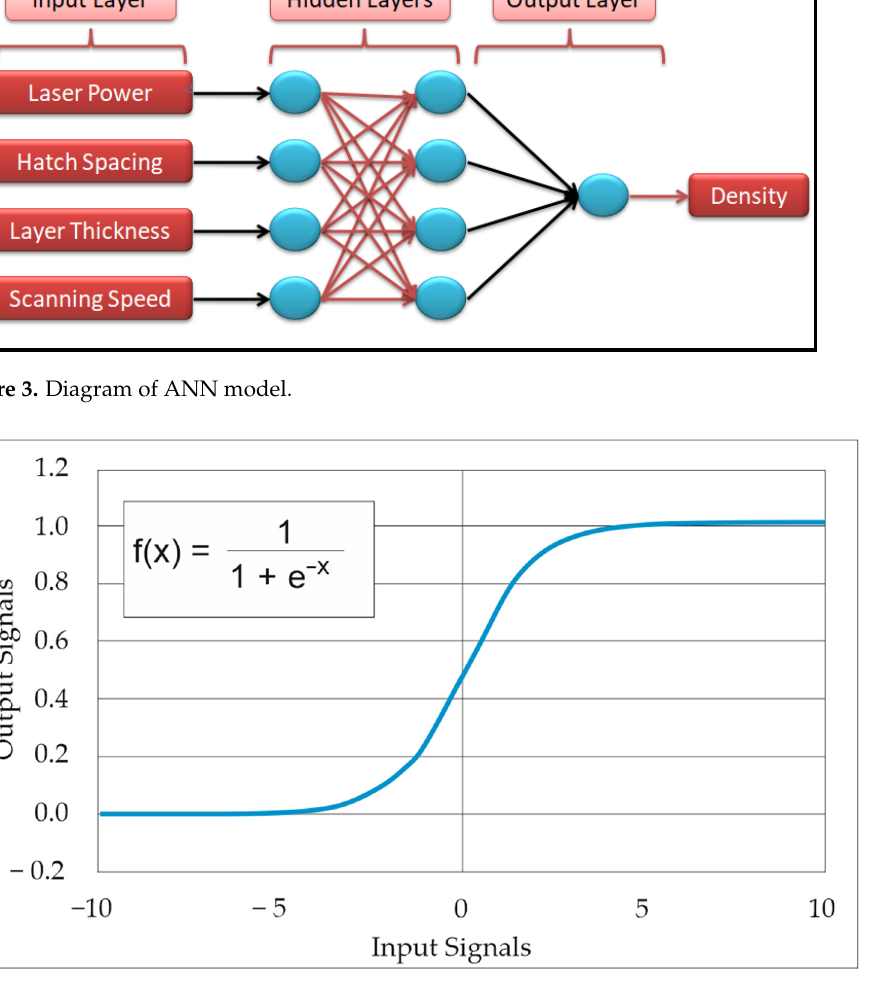
Figure 3. Diagram of ANN model.